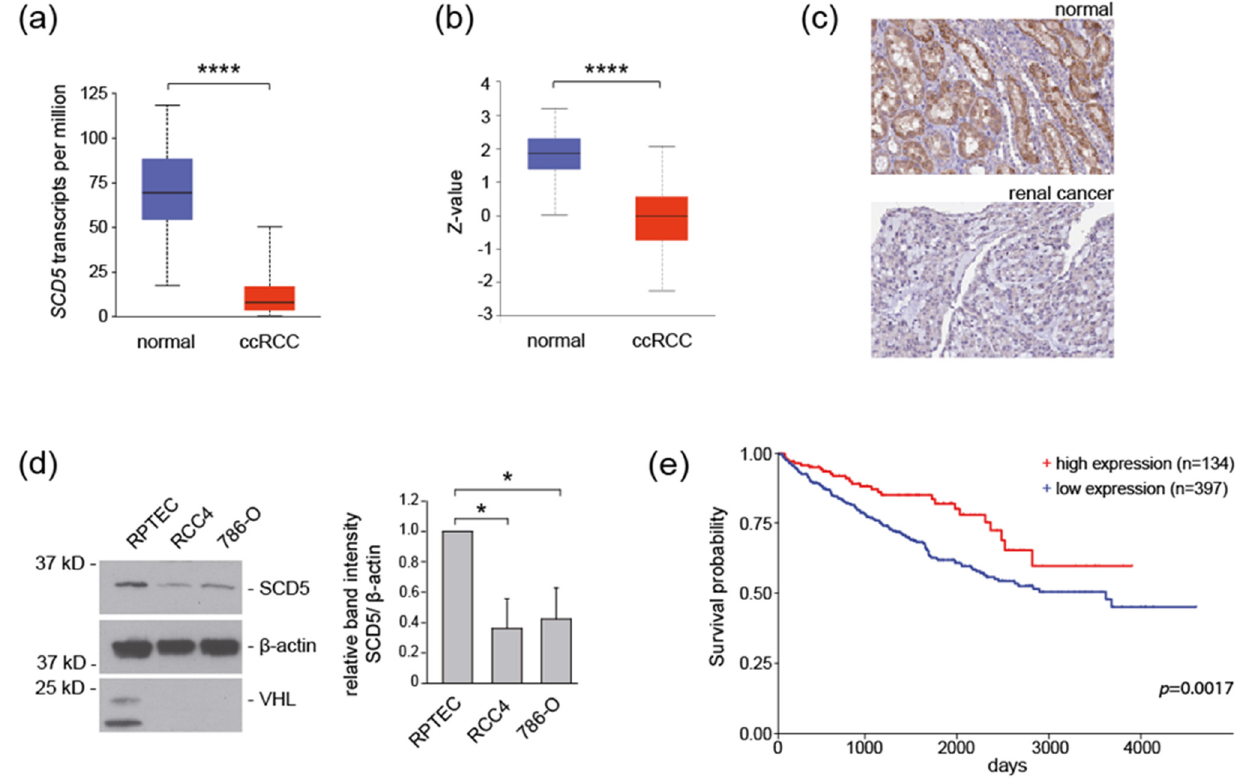
Figure 1. SCD5 is downregulated in VHL -deficient ccRCC tumors and cell lines. ( a ) Expression of SCD5 mRNA in TCGA ccRCC ( n = 533) and normal kidney samples ( n = 72). **** p < 0.0001. The analysis was performed using the UALCAN/TCGA platform. ( b ) SCD5 protein expression is reduced in ccRCC ( n = 110) compared to normal kidney samples ( n = 84) (CPTAC dataset). **** p < 0.0001.